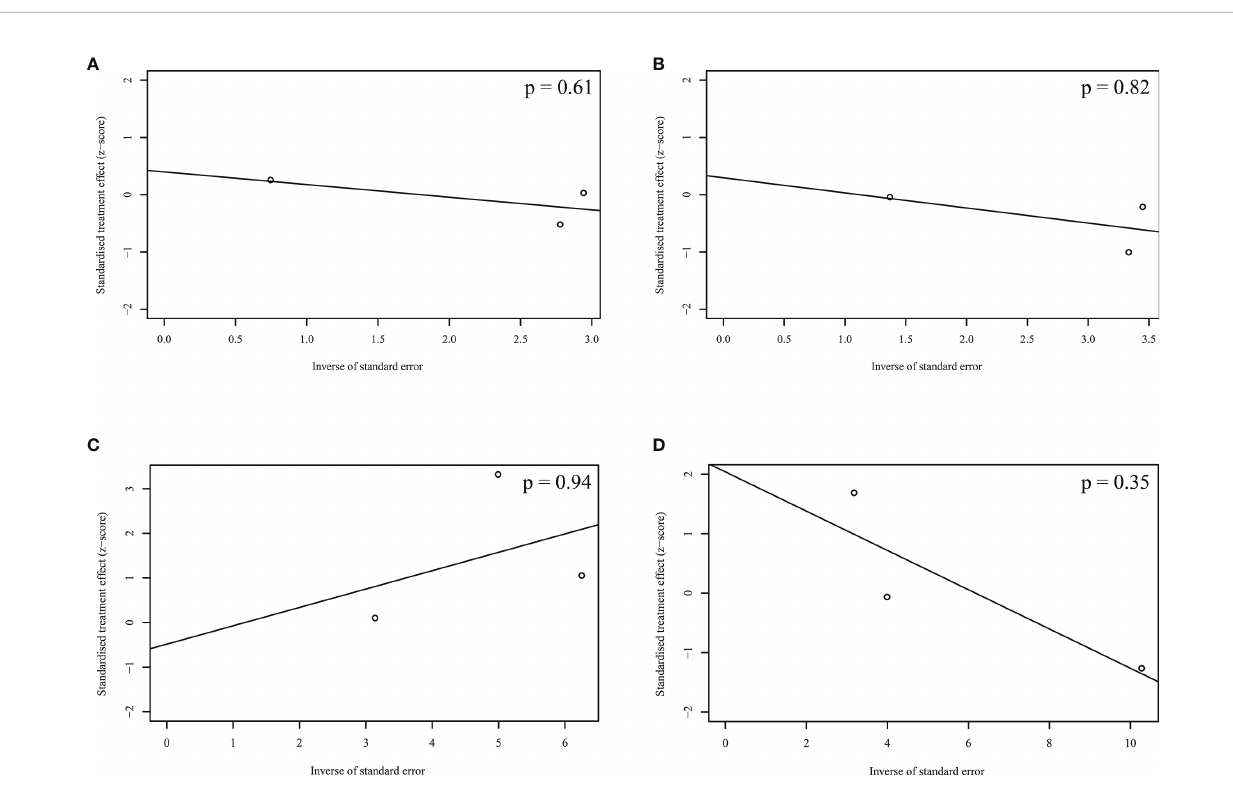
FIGURE 4 | Publication bias acrossing the enrolled studies. (A) Overall survival; (B) Progression-free survival; (C) Objective response rate; (D) Discontinuation